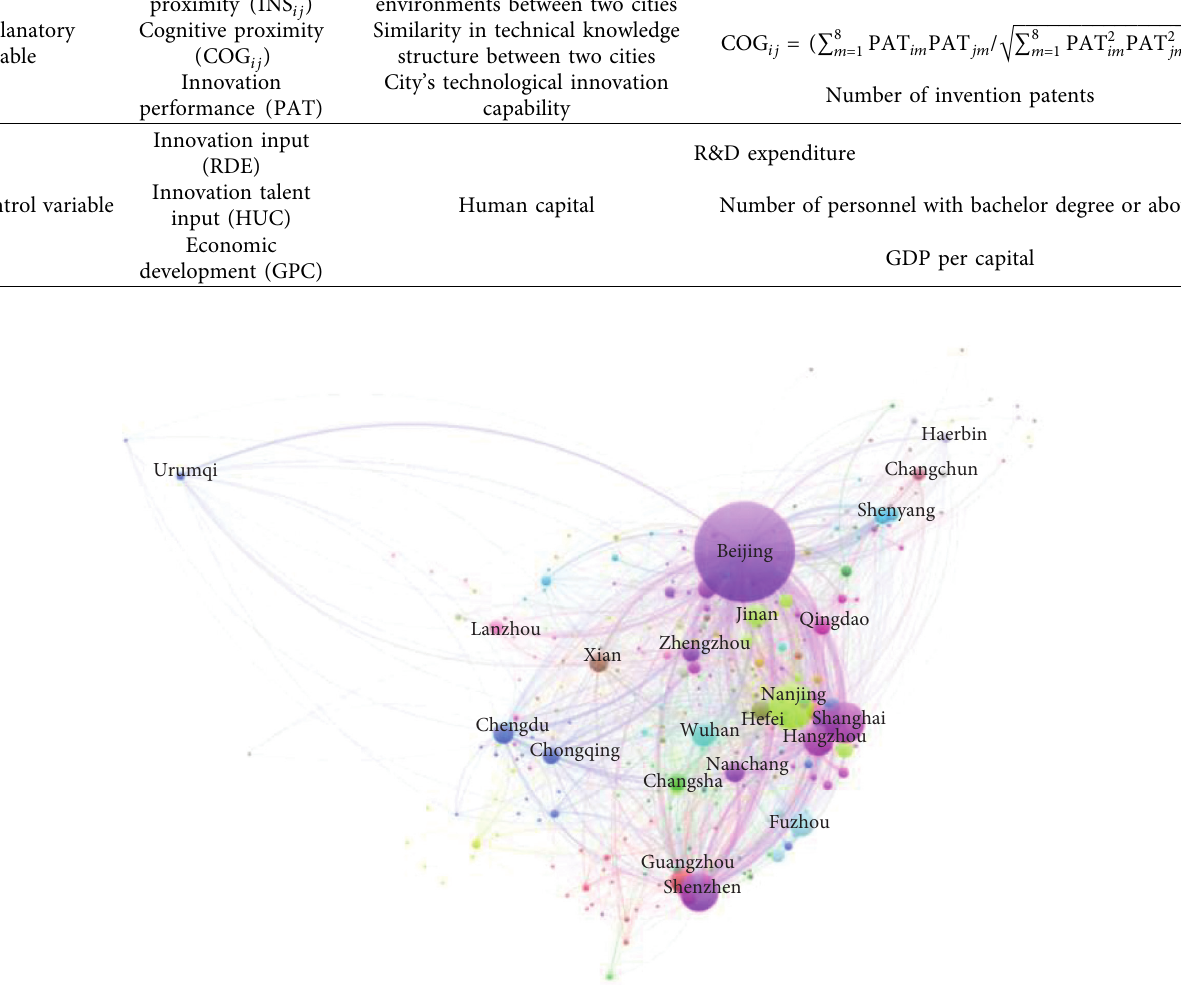
Figure 1: Topological structure of China’s intercity innovation networks in